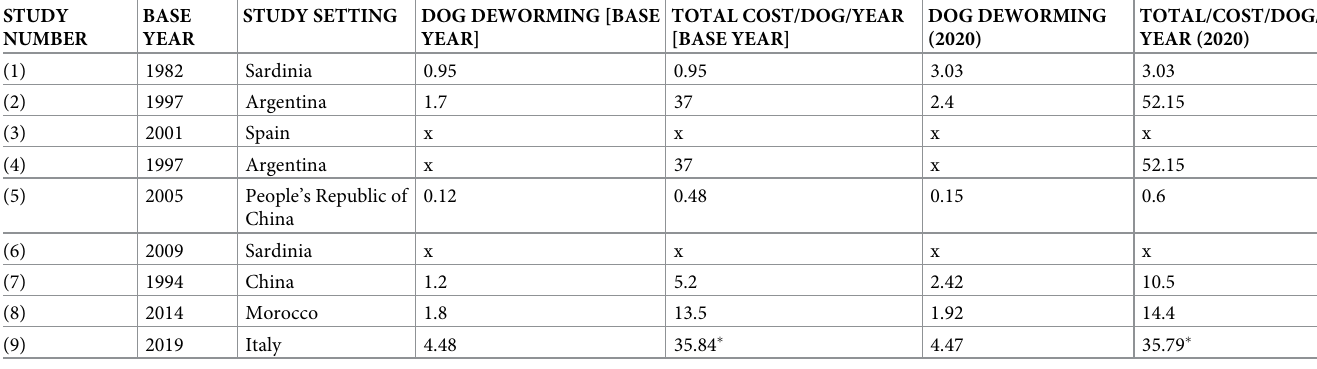
Table 5. Costs, adjusting for inflation, for control of CE